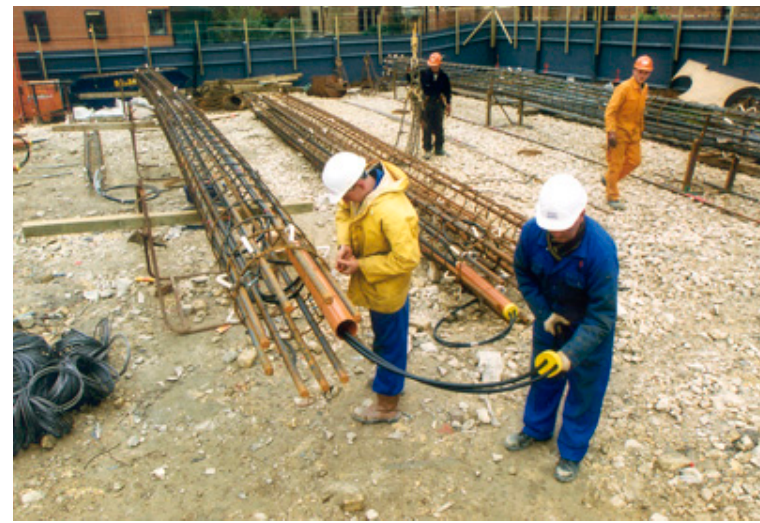
Figure 5. Laying the heat exchanger pipes in the load-bearing pile structure [55].